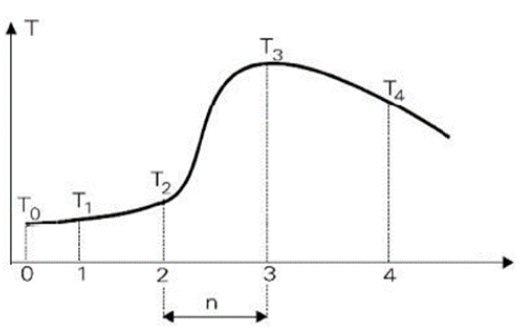
Figure 3. A sample graph of the calorimetric measurement for the calorimeter KL-10.